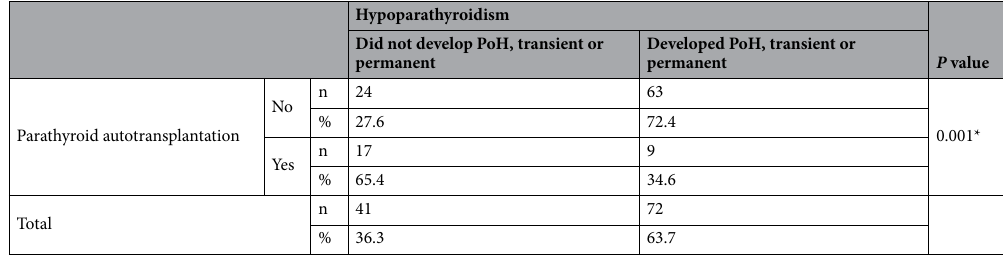
Table 4. Comparison of the development of temporary hypoparathyroidism in patients with and without parathyroid autotransplantation. n Number. *Continuity Correction test used.